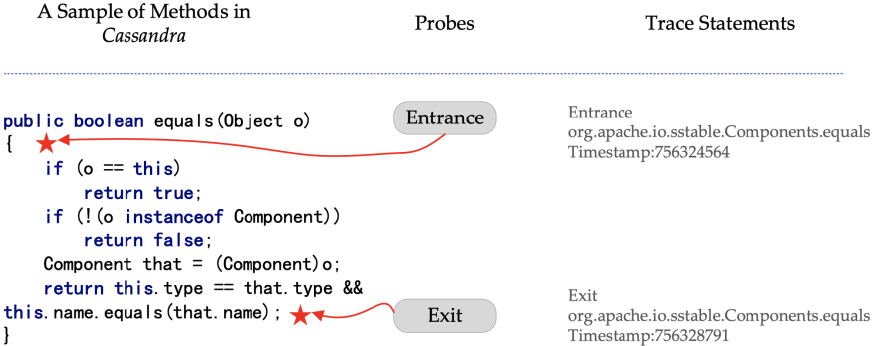
Figure 1. An example of trace information.